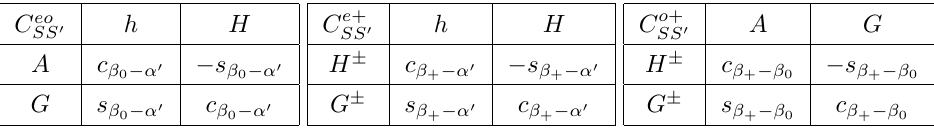
Table 6 . Coe(cid:14)cients for the couplings between two scalars and one gauge boson.